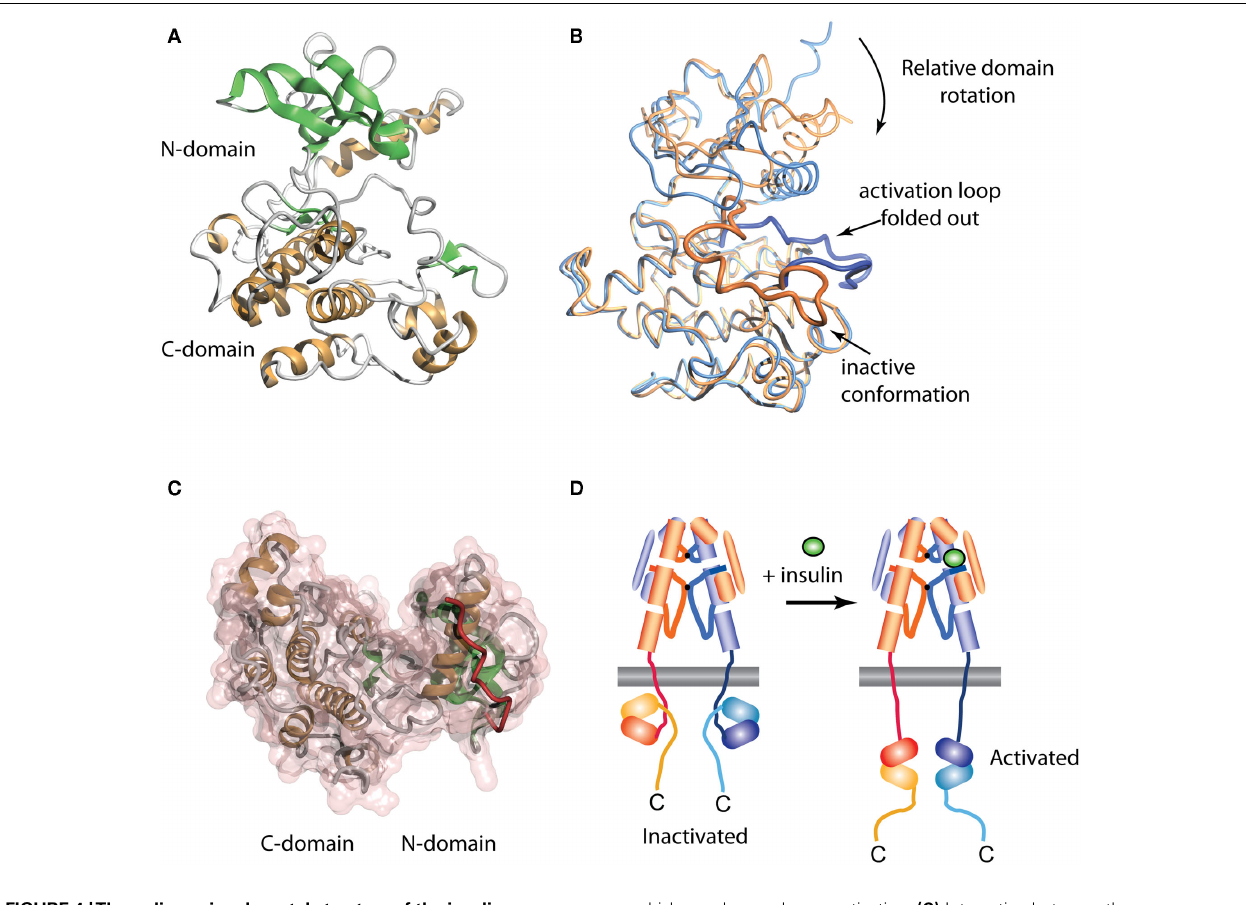
FIGURE 4 |Three-dimensional crystal structure of the insulin receptor tyrosine kinase domain. (A) Inactive form, showing the secondary structure of the N- and C-terminal domains. (B) Overlay of the inactive (blue, PDB entry 1IRK) and activated (orange, PDB entry 1IR3) forms of the domain, showing the displacement from the catalytic site of the activation loop (residues 1149–1170, highlighted as a thicker ribbon within each form) and the concomitant domain rotation